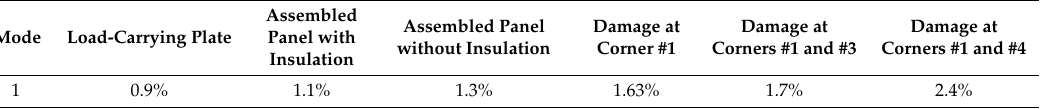
Figure 18. Deformation response and spectral data of the damaged TPS panels: ( a ) deformation response and ( b ) spectral data of damage at corner 1, ( c ) deformation response and ( d ) spectral data of damage at both corners 1 and 3, and ( e ) deformation response and ( f ) spectral data of damage at both corners 1 and 4. Table 4. Summary of the damping ratio of the first natural